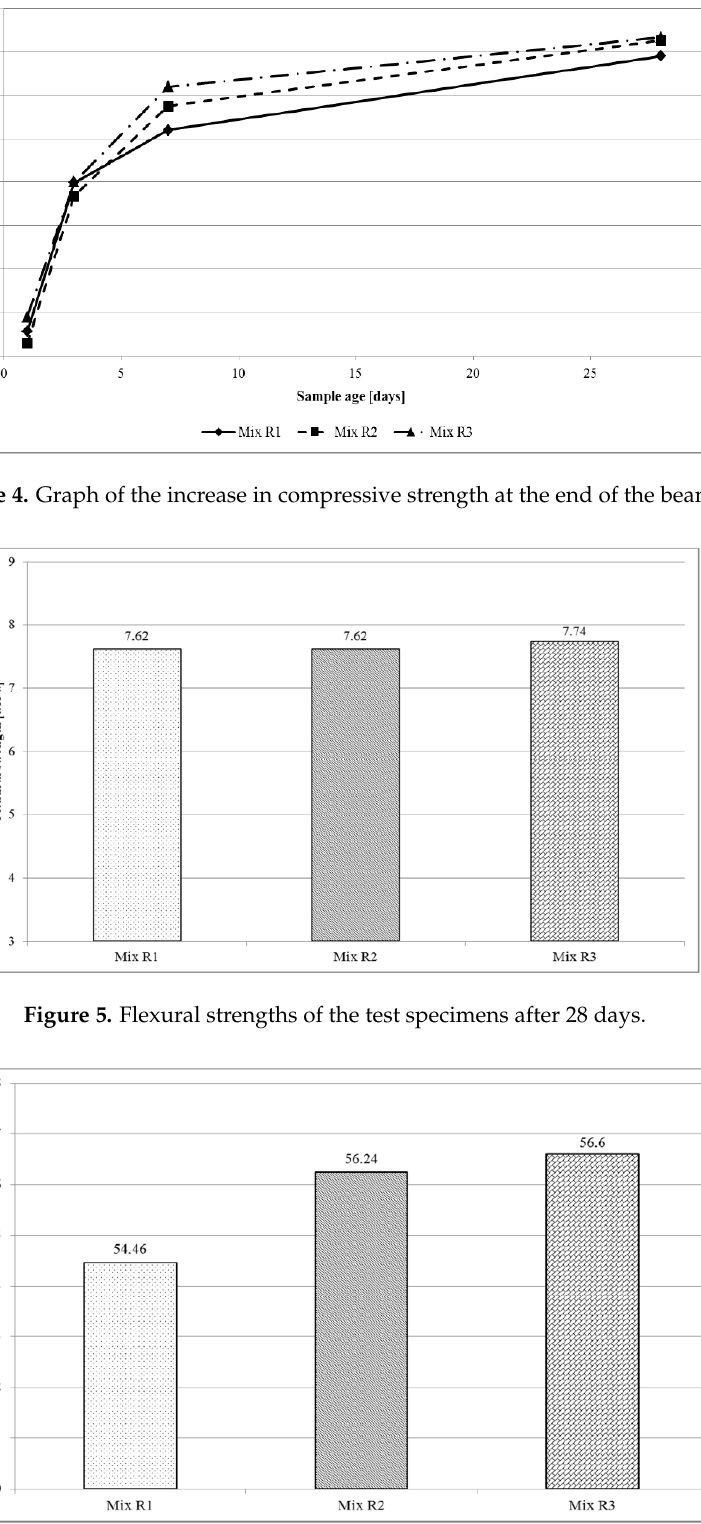
Figure 6. Compressive strength of the test specimens at the end of the beams after 28 days.